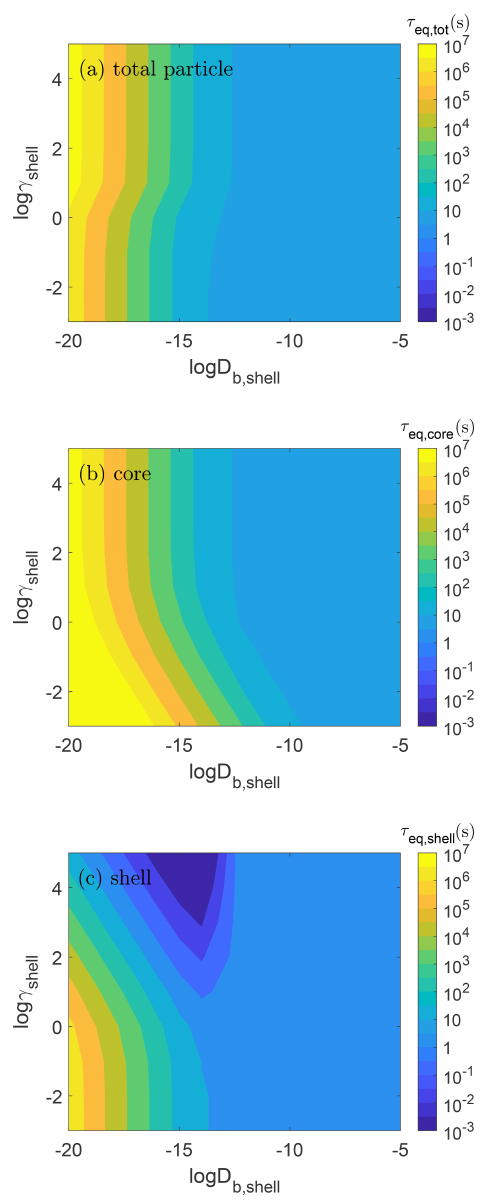
Figure 3. Equilibration timescales of semi-volatile species ( C 0 = 10µgm − 3 ) in (a) total particle ( τ eq , tot ), (b) core ( τ eq , core ), and (c) shell ( τ eq , shell ) as a function of the activity coefficient ( γ shell ) and bulk diffusivity in the shell ( D b , shell